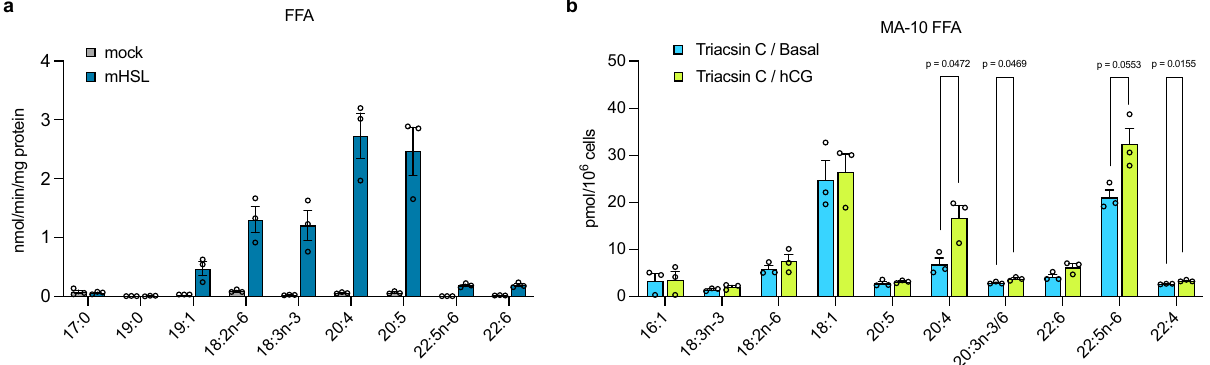
Fig. 5 HUFA-containing cholesteryl ester species are preferred substrates for HSL. a The lipase activity of recombinant mouse hormone-sensitive lipase (mHSL). HEK293T cells were transfected with empty vector (mock) or mHSL-expressing vector (mHSL) and the cell lysate (1 mg/mL) was incubated with each cholesterol ester species (100 μ M) for 30 min at 37 °C. FFA, free fatty acid. n = 3 for each group. b HSL-dependent FFA liberation upon human chorionic gonadotropin (hCG) stimulation in MA-10 cells. Triacsin C was pretreated to block the conversion of FFAs to fatty acyl-CoAs. The FFA levels insensitive to HSL-IN-1 were subtracted to evaluate HSL-dependent FFA production. n = 3 for each group. Signi fi cance is based on unpaired two-tailed t - test with Welch ’ s correction. Data shown are the mean ± SEM. The detailed data are shown in Supplementary Fig.